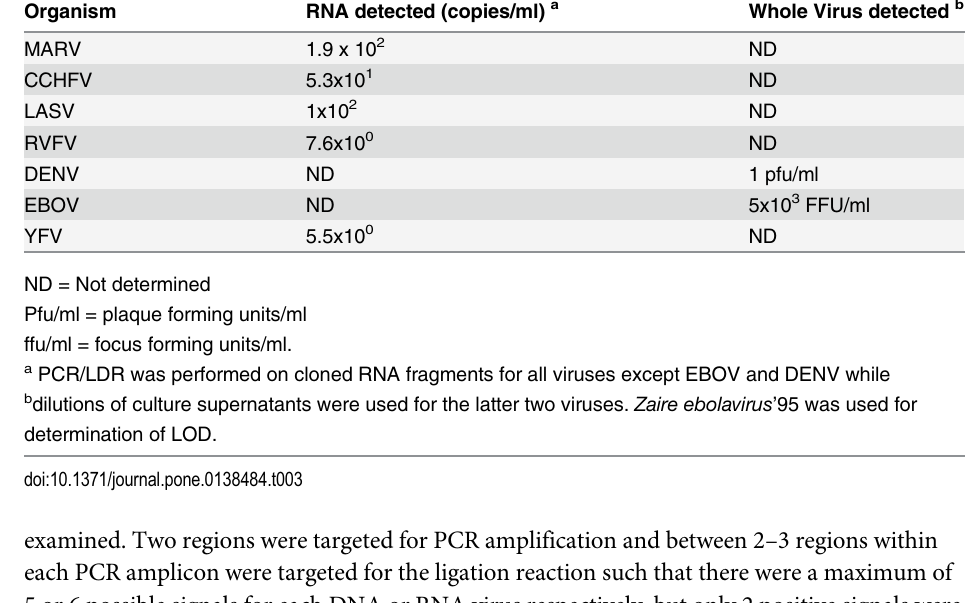
Table 3. The limit of detection of the PCR/LDR/Universal Array assay using in vitro transcribed RNA or whole virus.